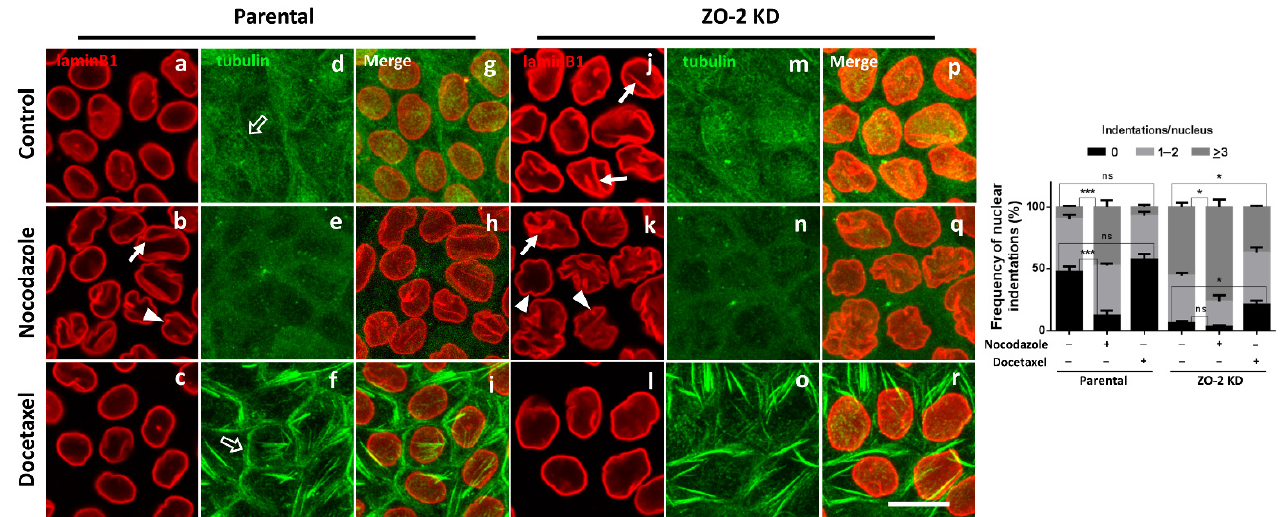
Figure 5. Stabilization of microtubules with docetaxel inhibits nuclear lobulation and indentation in ZO-2 KD MDCK cells. Parental and ZO-2 KD MDCK cells were incubated for 4 h with 10 µ M nocodazole or with 10 µ M docetaxel. Monolayers were fixed and processed for immunofluorescence with antibodies against lamin B1 and tubulin. Left panel, bar, 20 μ m; full arrows, nuclear lobulations; full arrowheads, nuclear indentations; empty arrows, microtubules at cell borders. Right panel, quantitative analysis. Statistical analysis was done with One-way ANOVA followed by Tukey’s multiple comparisons test. Results shown as media ± standard deviation. ns, non-significant, * p < 0.05, *** p = 0.001.